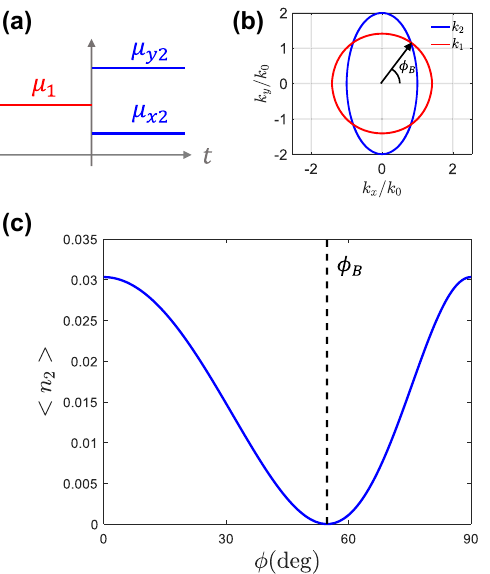
Figure 5: Anisotropic temporal boundaries with intersecting isofrequencies. (a) Sketch of an anisotropic temporal boundary, = 𝜇 ( ̂ x ̂ x + ̂ y ̂ y ), is suddenly where an isotropic medium, 𝝁 1 1 ̂ x ̂ x + 𝜇 ̂ y ̂ y . The = 𝜇 transformed into an anisotropic medium, 𝝁 2 x 2 y 2 = 𝜀 = 1. (b) pemittivity is assumed to be unity in both cases, 𝜀 1 z 2 z Isofrequency contours before and after the temporal boundary, for 𝜇 = 2, 𝜇 = 1 and 𝜇 = 4. (c) Photon production for modes with a 1 2 x 2 y common wavenumber k as a function of the angle of propagation 𝜙 . The dashed black line indicates the angle √ 𝜇 = − 𝜇 − 𝜇 sin 𝜙 ( 𝜇 ) ∕ 𝜇 ( 𝜇 ) where the isofrequency 1 1 B y 2 x 2 x 2 y 2 contours cut, corresponding to a zero of photon